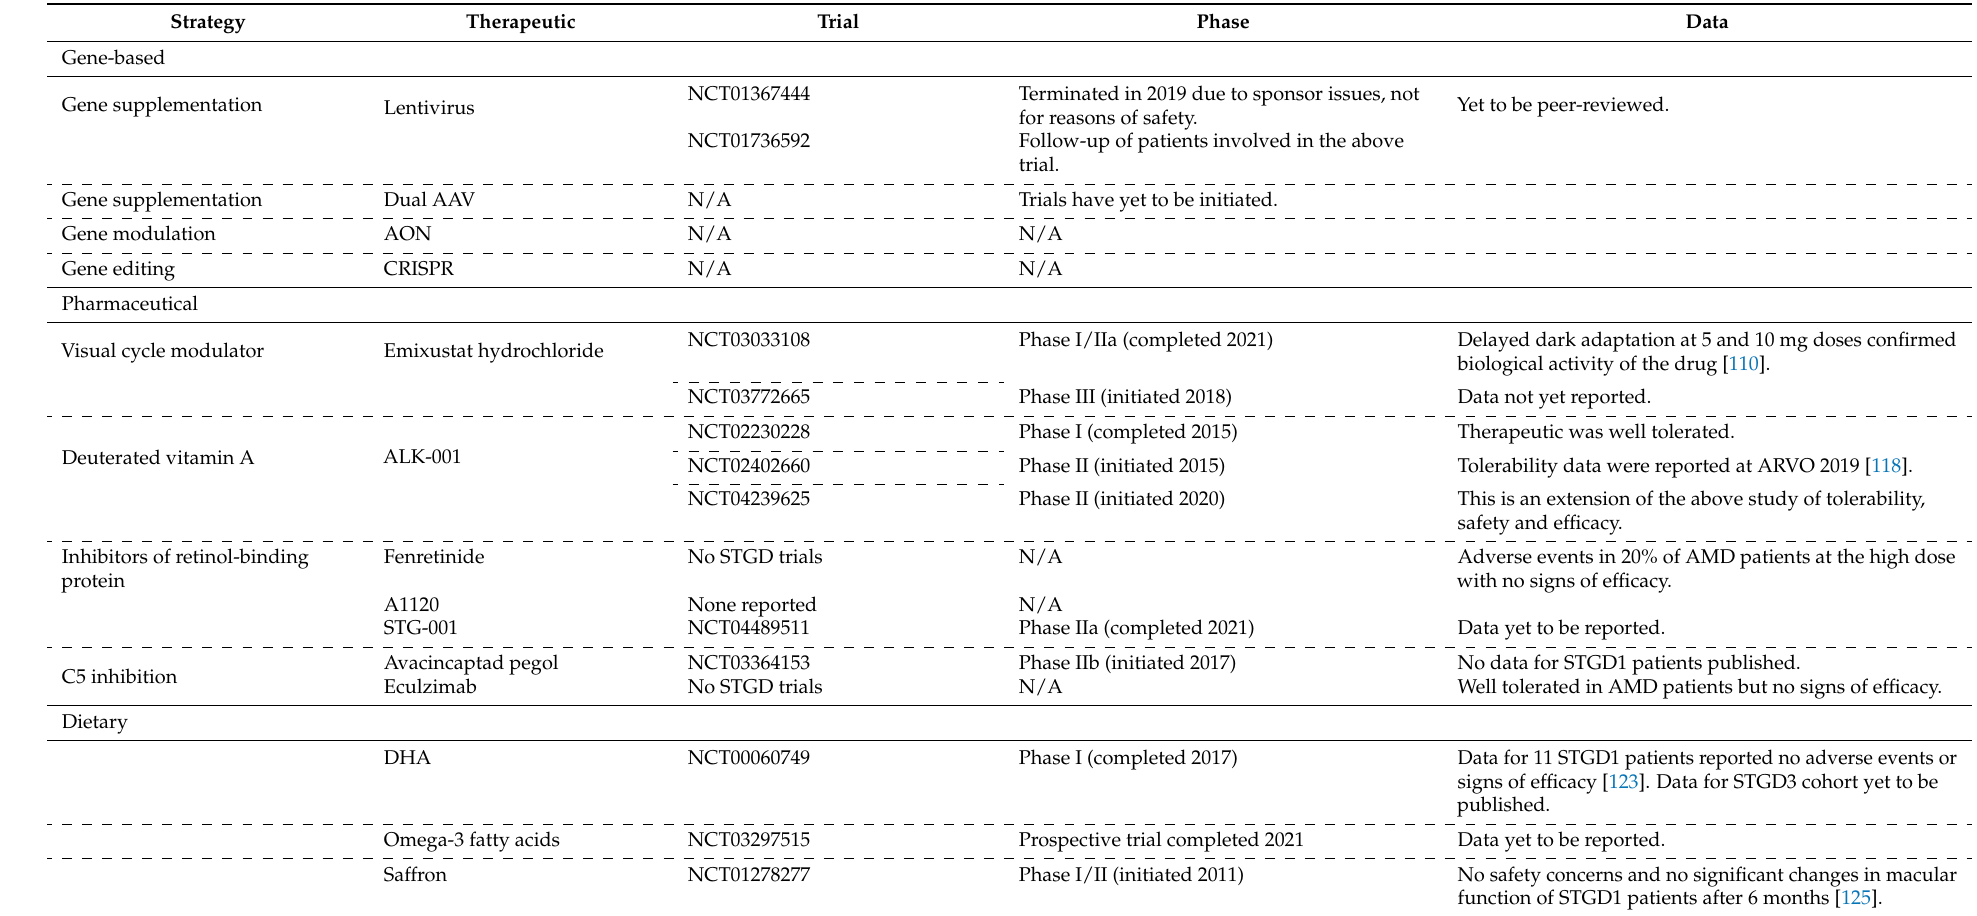
Table 2. Summary of therapeutic approaches for Stargardt disease and related clinical trials. AAV = adeno-associated virus; AMD = age-related macular degeneration; AON = anti-sense oligonucleotide; BMSC = bone-marrow-derived stem cells; CRISPR = clustered regularly interspaced short palindromic repeats; DHA = docosahexaenoic acids; ESC = embryonic stem cells; N/A = not applicable; RPE = retinal pigment